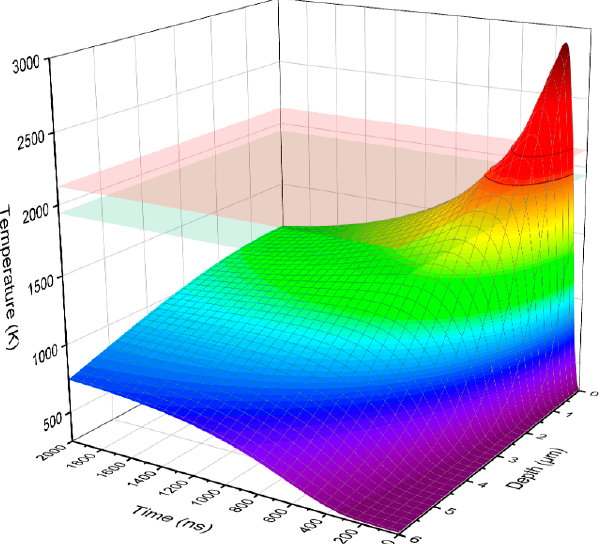
Figure 2. Spatiotemporal evolutions of temperature of the Ti substrate with 400 nm Cr film induced by IPIB irradiation, with an energy density of 2 J/cm 2 .